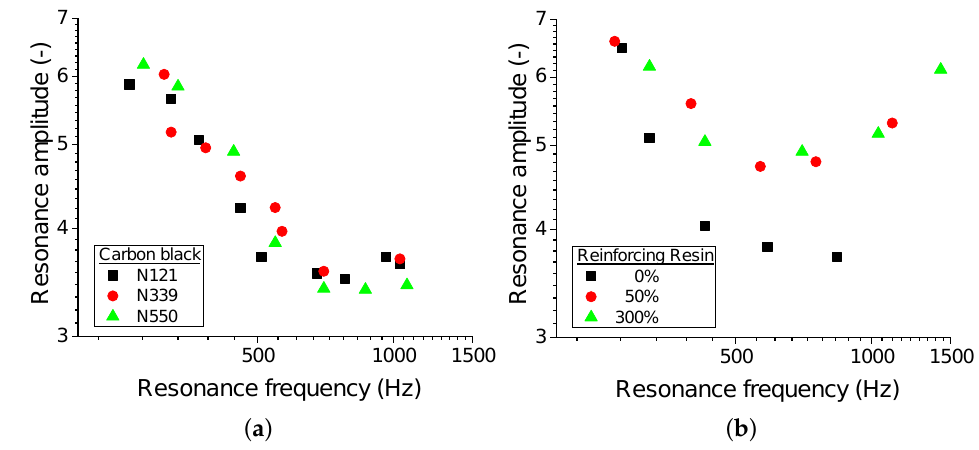
Figure 6. The resonance amplitude as a function of resonance frequency for ( a ) different carbon black grades within a SSBR matrix without resin and ( b ) carbon-black-filled IR with three resin concentrations; 0.0, 1.4, and 9.2 parts per hundred